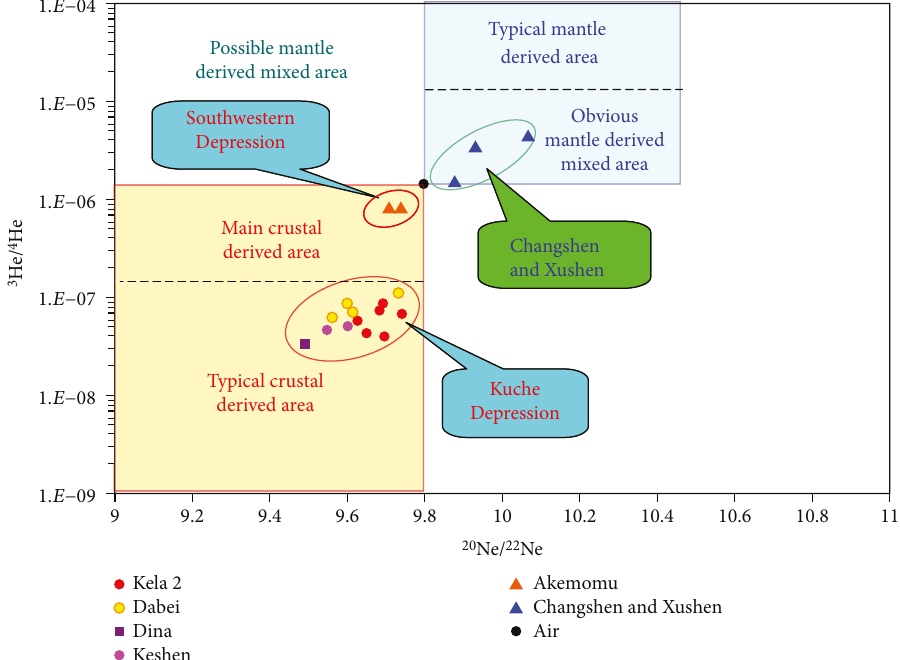
Figure 7: Genesis identi fi cation of 3 He/ 4 He- 20 Ne/ 22 Ne for some gas fi elds from the Kuche and Southwestern Depressions, Tarim Basin (chart modi fi ed from